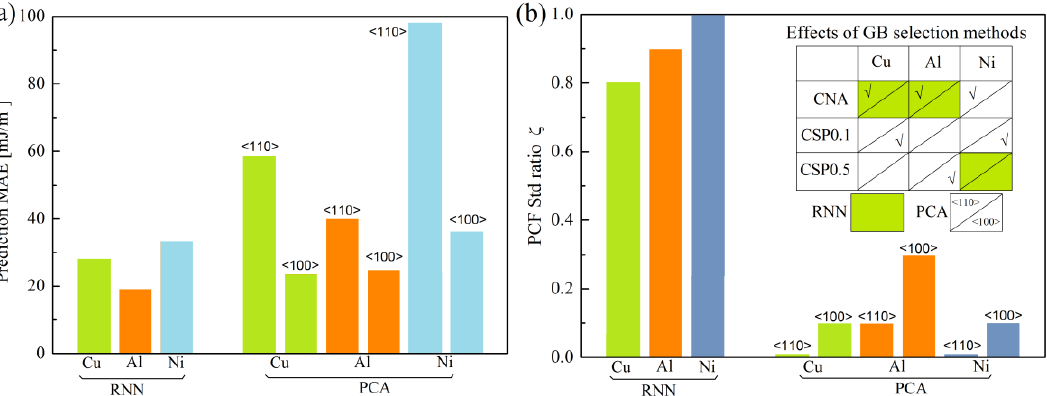
Figure 6. ( a ) Lowest MAE and ( b ) the variation of PCF standard deviation ratio at the lowest MAE for PCA and RNN predictions. Inset in figure ( b ) shows which GB selection methods yield the lowest MAEs for PCA and RNN predictions.